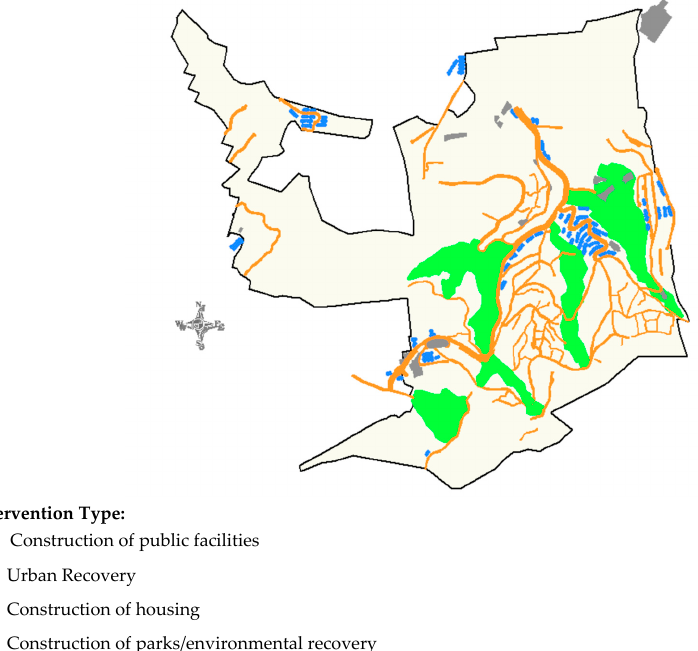
Figure 1. Belo Horizonte City—Limits of the regions, Slums with intervention, Slums without intervention and Other Slums. Int. J. Environ. Res. Public Health 2019 , 16 , x